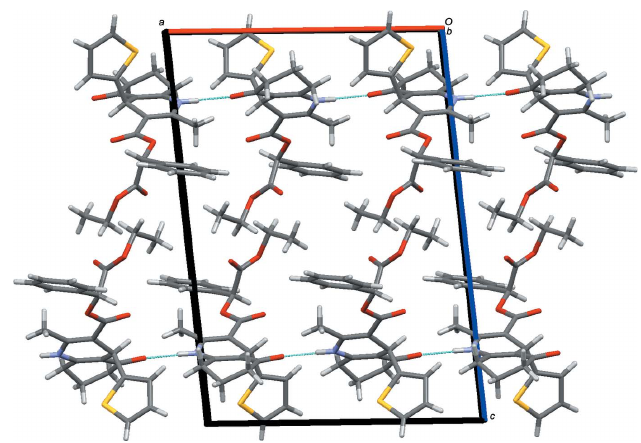
Figure 2 A packing diagram of the title compound, viewed along the b -axis